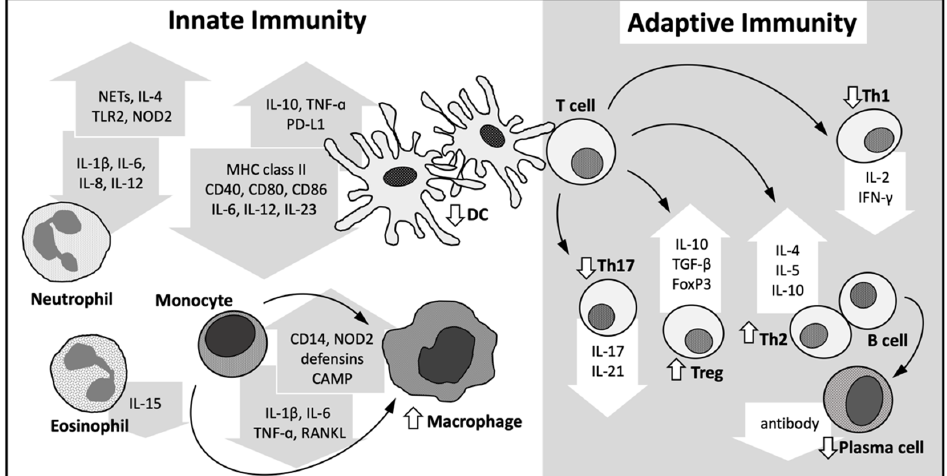
Figure 3. The impact of vitamin D on immune cells. Vitamin D stimulates macrophage differentiation, induces the production of proinflammatory cytokines, and promotes antimicrobial peptide expression as well as PRP in monocytes and macrophages. It decreases the differentiation, maturation, and antigen presentation ability of dendritic cells while decreasing the production of IL-6, IL-12, and IL-23. Vitamin D induces formation of NETs and PRP expression but suppresses proinflammatory cytokines in neutrophils. It promotes the release of IL-4 from neutrophils yet decreases eosinophil IL-15 production. An immunomodulatory role of vitamin D in dendritic cells is also observed through the increase in IL-10 secretion and the induction of T-cell apoptosis via the expression of PD-L1 and TNF in Tregs. By moving helper T cells toward a more tolerogenic state, vitamin D directly induces Th2 and Treg differentiation, and downregulates proinflammatory Th1 and Th17 lymphocytes. Additionally, mediated via vitamin D-VDR signaling, decreased proliferation of B cells and its differentiation to plasma cells can lead to low antibody production. Abbreviations: PRP—pattern recognition